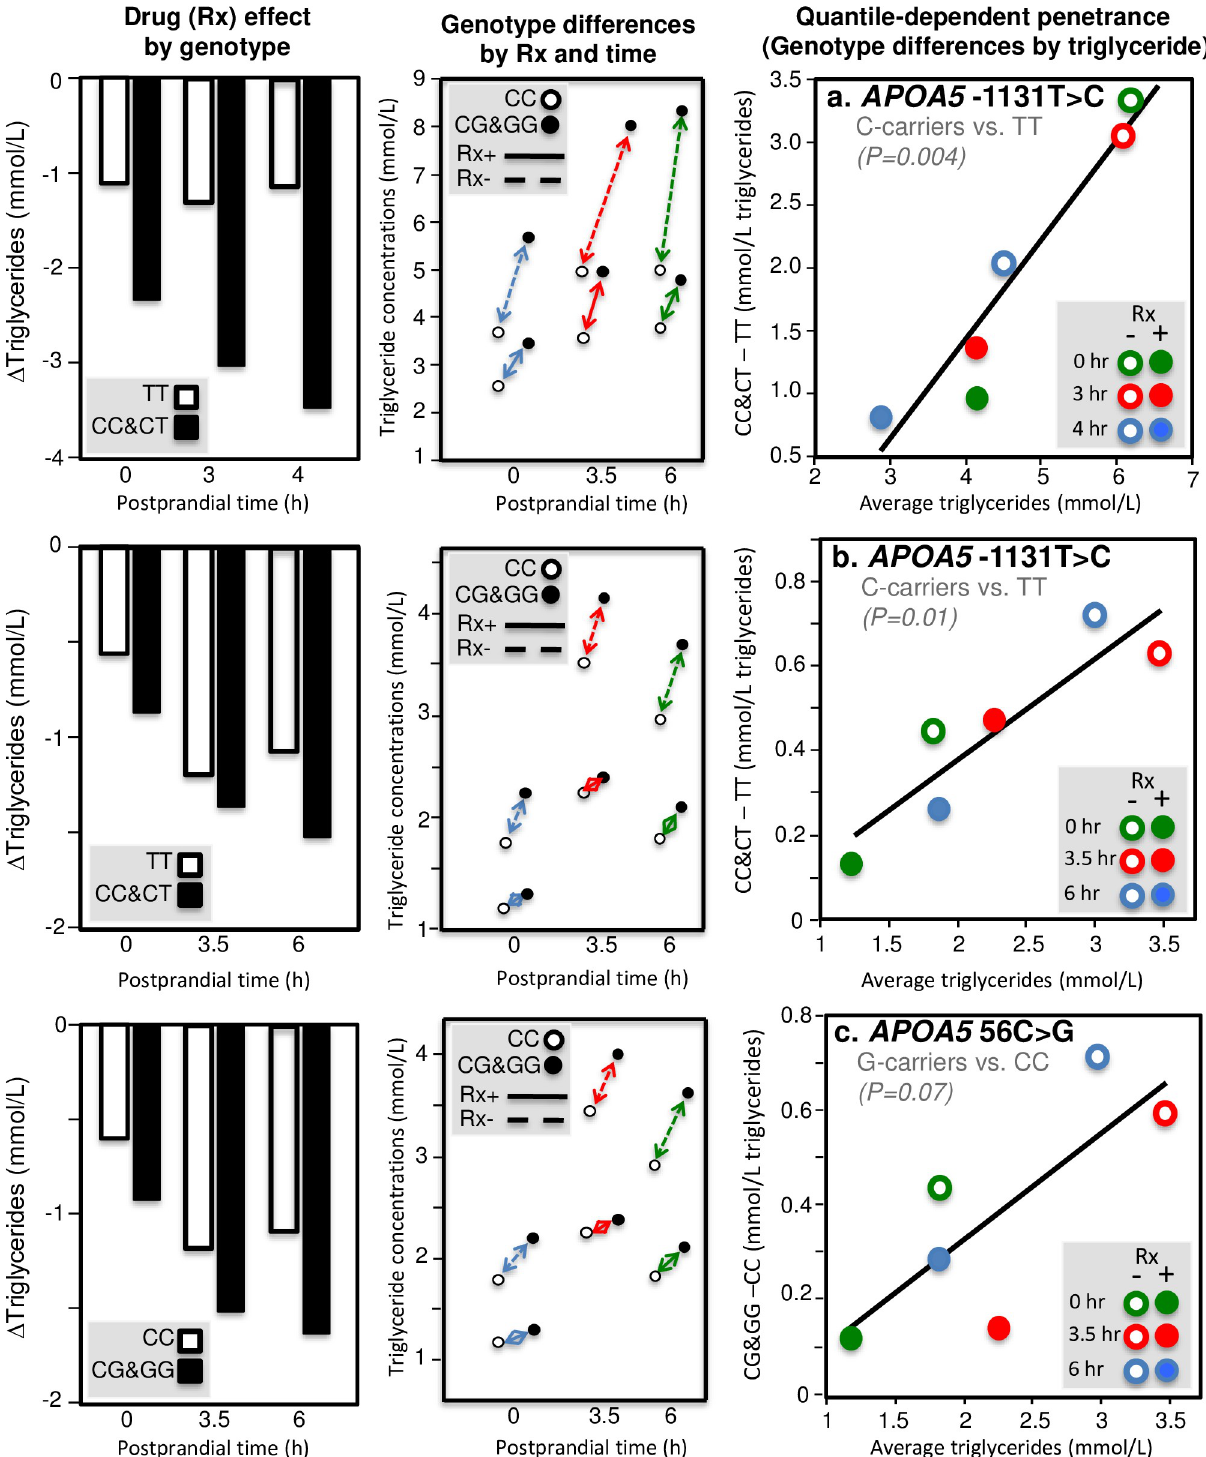
Fig 10. Quantile-dependent expressivity plots for pre- and post-fenofibrate treated postprandial triglyceride responses by APOA5 genotypes. Derived from data presented by Cardona et al. for the -1131T > C of the APOA5 gene (top row) [16] and Lai et al. for the -1131T > C (middle row) and 56C > G polymorphisms (bottom row) of the APOA5 gene [63]. Left column presents pre vs. post fenofibrate treated triglyceride concentrations by genotype; center column present genotype-specific mean triglyceride concentrations by treatment and genotype by time since meal, and right column present quantile-dependent expressivity plot of the genetic effect size vs. average triglyceride concentrations, suggesting the effect sizes are largely attributable to their relationship to overall mean triglyceride concentrations. https://doi.org/10.1371/journal.pone.0229495.g010 PLOS ONE | https://doi.org/10.1371/journal.pone.0229495 February 26,